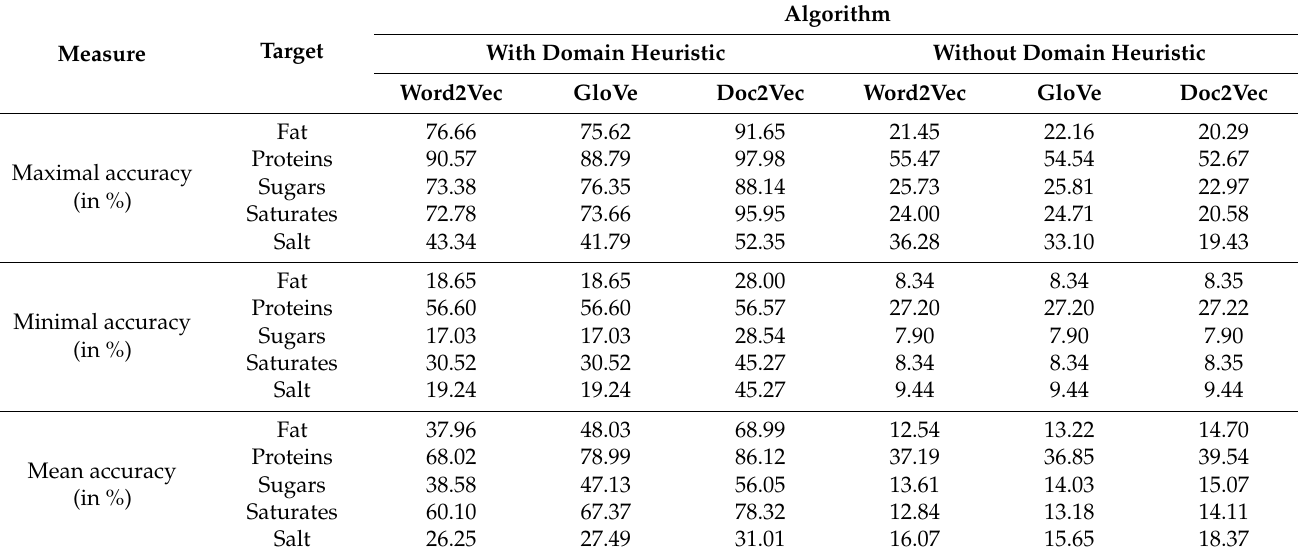
Table 2. Results from the evaluation on